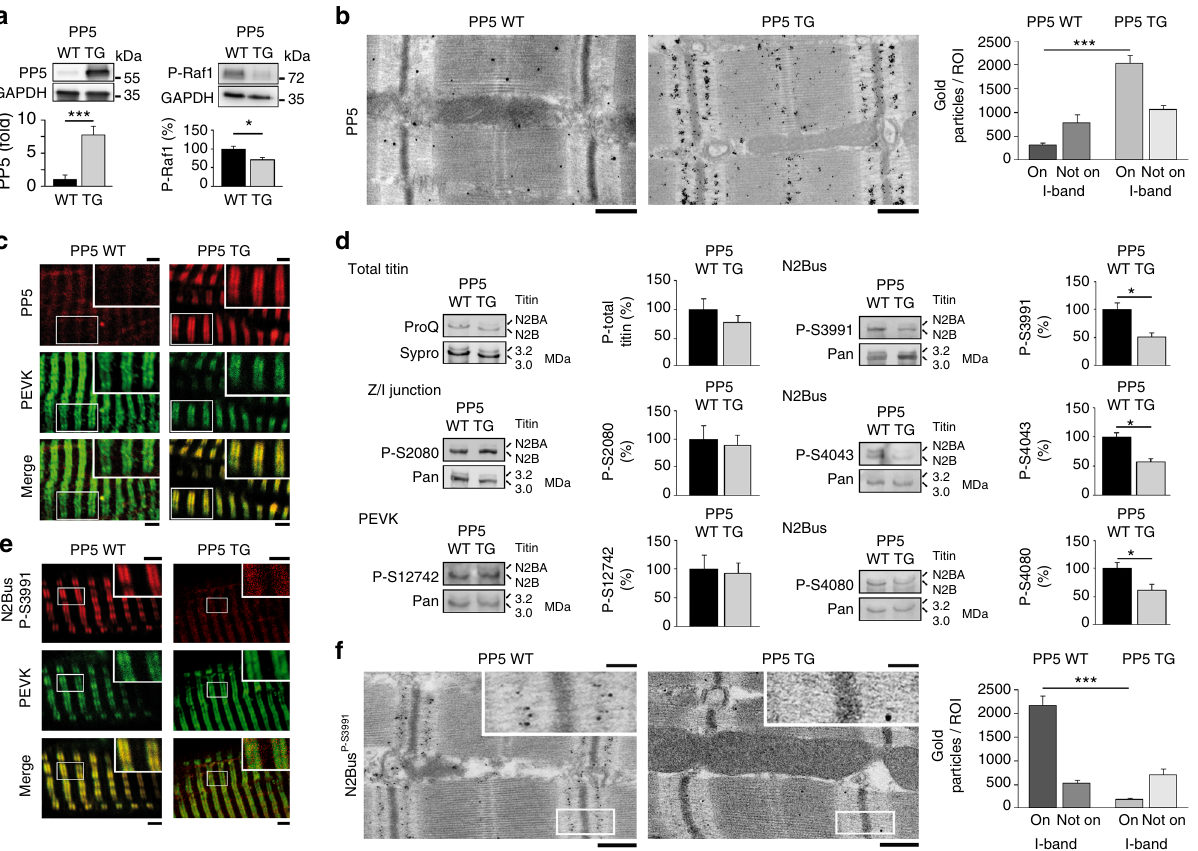
Fig. 4 PP5 and phospho-titin in PP5-overexpressing TG mouse hearts. a Expression level of PP5 (left) and phospho-Raf1 S338 (right) in PP5 TG vs. WT mouse hearts by western blot. mean ± s.e.m., n = 4 hearts/group (age 5 – 6 months); duplicate analysis/group. b Sarcomeric localization of PP5 in PP5 WT and TG hearts by immunogold electron microscopy. Bars, 500 nm. Bar graph shows average number of gold particles counted in 50- µ m 2 -sized regions-of- interest (ROI), either on the sarcomeric I-band or elsewhere in the cardiomyocyte ( ‘ Not on I-band ’ ). Data are mean ± s.e.m., n = 5 ROIs from 2 hearts/ group. c PP5 localization in cardiomyocytes from PP5 TG and WT mouse hearts by indirect immuno fl uorescence. PP5 antibody (secondary antibody: Cy3- conjugated IgG), counterstained with anti-PEVK (titin) antibody (secondary antibody: FITC-conjugated IgG). Bars, 2 µ m (main) and 1 µ m (insets). d PP5 overexpression speci fi cally decreases titin phosphorylation at N2Bus in PP5 TG vs. WT hearts. Total titin phosphorylation measured by ProQ Diamond/ Sypro Ruby staining (upper left), site-speci fi c titin phosphorylation detected by western blot using antibodies to P-S3991, P-S4043, P-S4080 (all N2Bus; right panels), P-S2080 (titin Z/I junction), and P-S12742 (PEVK region). Phospho-titin signals were normalized to total titin signals detected by WB using a panel of sequence-speci fi c antibodies (Pan). Means were indexed to those of control (WT) groups. Data are mean ± s.e.m., n = 4 hearts/group, samples analyzed in triplicate. e Localization of phospho-N2Bus P-S3991 in cardiomyocytes from PP5 TG and WT hearts by indirect immuno fl uorescence. Anti- N2Bus P-S3991 antibody (secondary antibody: Cy3-conjugated IgG), counterstained with anti-PEVK antibody (secondary antibody: FITC-conjugated IgG). Bars, 2 µ m (main) and 1 µ m (insets). f Sarcomeric localization of phospho-N2Bus P-S3991 in PP5 WT and TG hearts by immunogold electron microscopy. Bars, 500 nm (main) and 100 nm (insets). Bar graph shows average number of gold particles counted in 50- µ m 2 -sized regions-of-interest (ROI), either on the sarcomeric I-band or elsewhere in the cardiomyocyte ( ‘ Not on I-band ’ ). Data are mean ± s.e.m., n = 5 ROIs from 2 hearts/group. In a and d , bar graphs show relative signal changes indexed to the respective controls. In a , b , d , and f , * p < 0.05 and *** p < 0.001, by two-tailed Student ’ s t